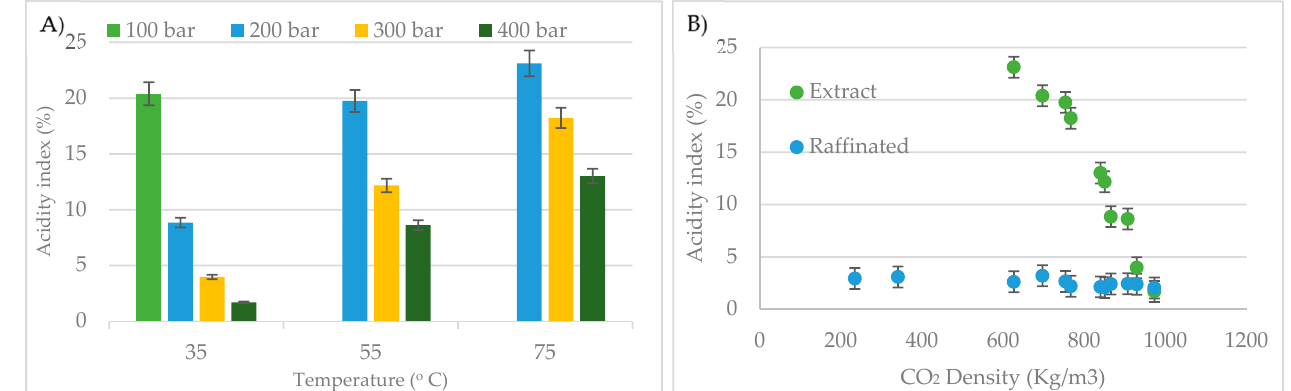
Figure 4. Effect of temperature and pressure ( A ) as well as density ( B ) on the acidity index of the crude borage oil fractions (mean ± SD).